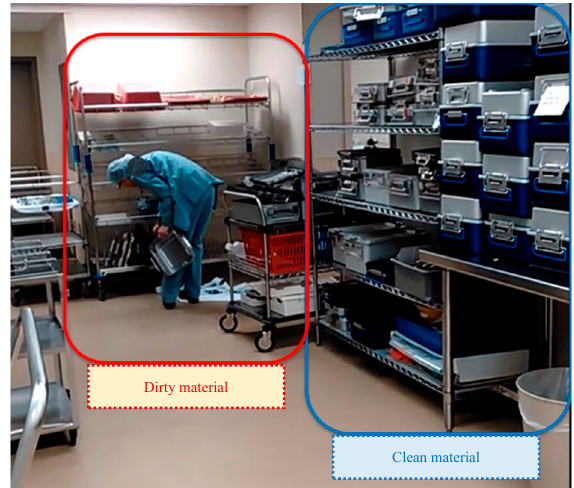
Figure 8. Dirty and clean materials placed in the same area.